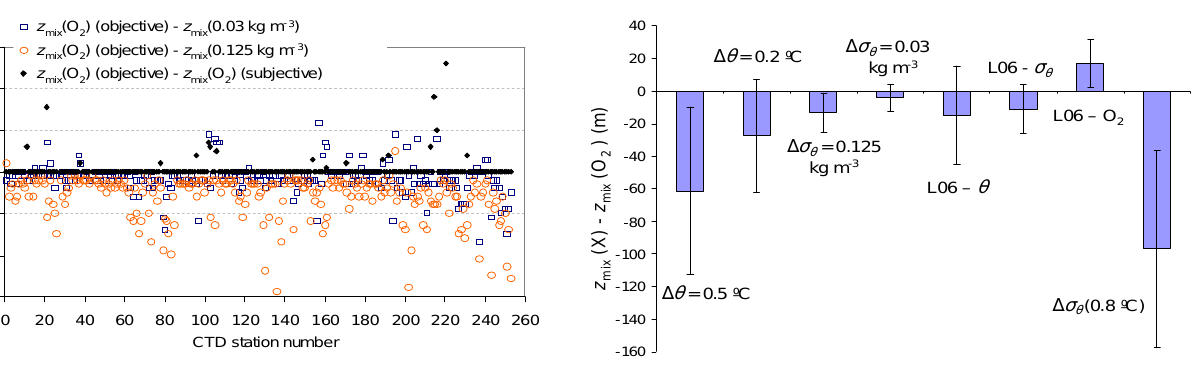
Fig. 5. Mean difference between z mix based on potential temper- ature or density differences or oxygen saturation state ( z mix (X)) to z mix (O 2 ) . L06 is the algorithm used by Lorbacher et al. (2006) to define z mix based on potential temperature (L06- θ ) and potential density (L06- σ θ ) . The 1σ θ (0.8 ◦ C) criterion is based on the differ- ence in density given by a temperature difference of 0.8 ◦